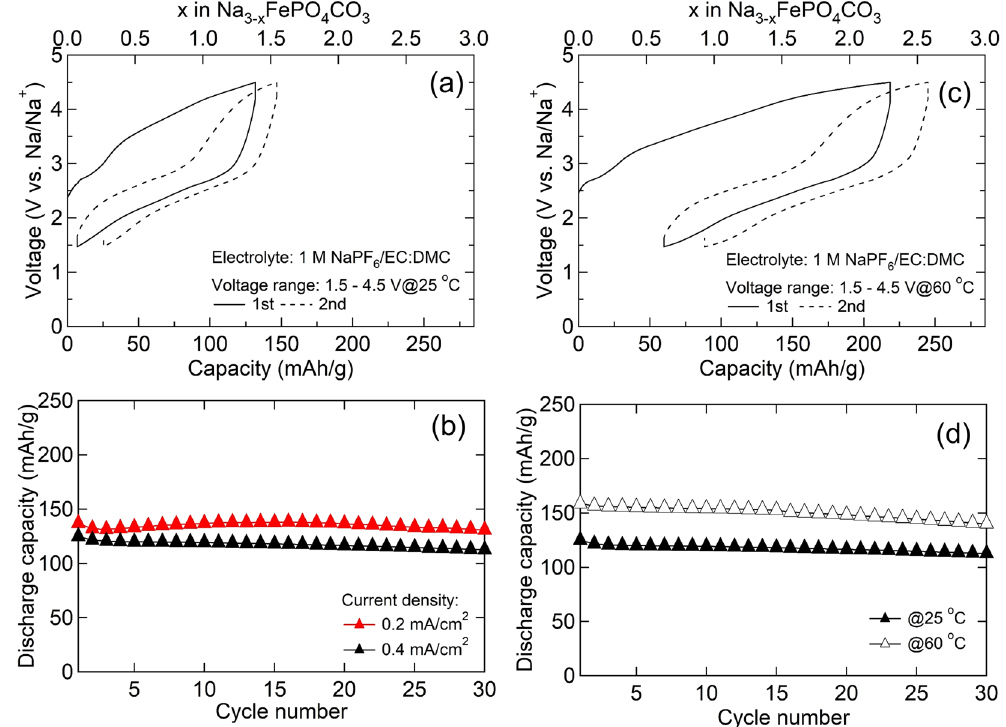
Figure 5. The initial charge-discharge curves obtained between 1.5 and 4.5 V at the current density of 0.4 mA/ cm 2 at 25 °C ( a ); the cyclability is on the bottom side ( b ); the initial charge-discharge curves obtained between